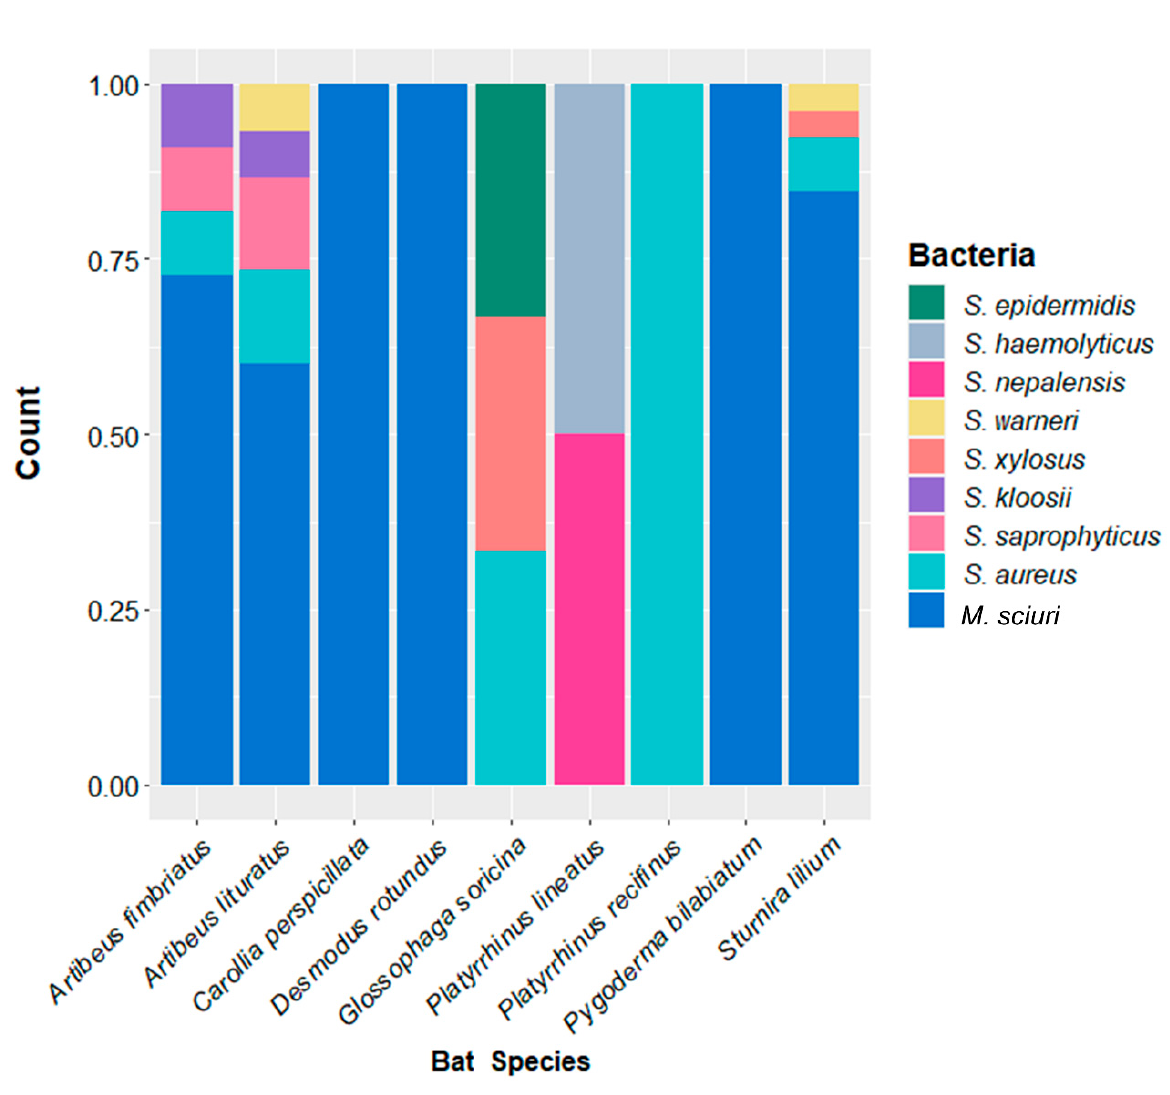
Figure 1. Stacked bar plot showing the relative abundance of Staphylococcaceae isolated from the skin of each bat species.